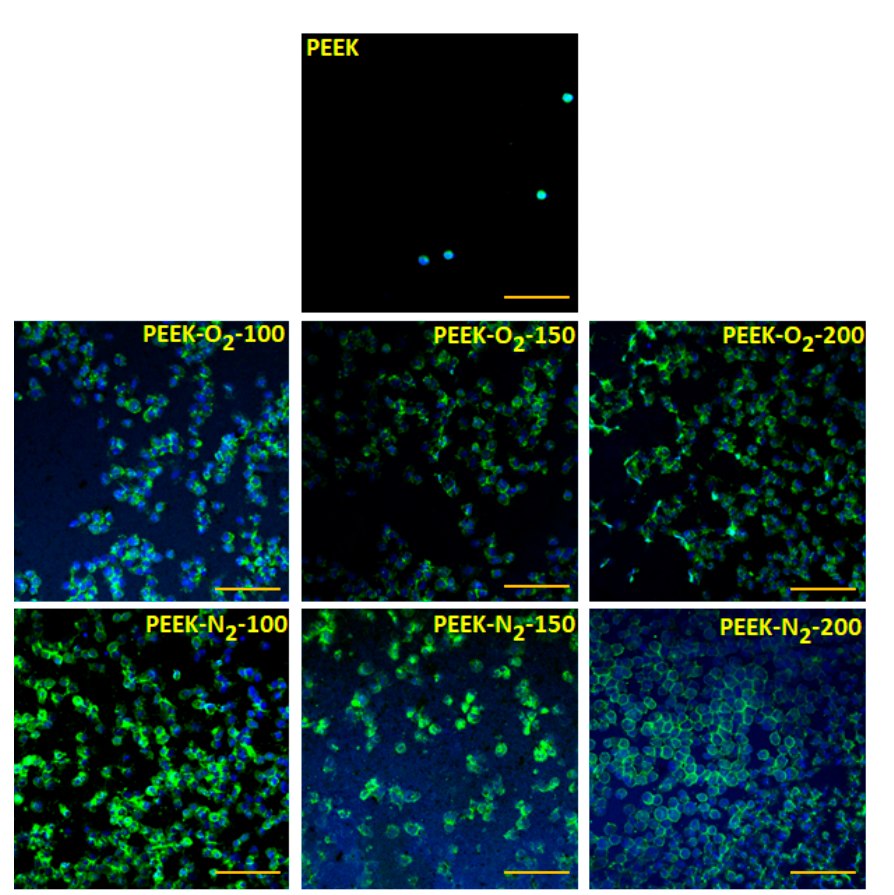
Figure 8. MG63 adhesion to the analyzed materials after 12 h of culture. Scale bar: 100 µm. Blue staining—nucleus (DAPI), green staining—actin (AlexaPhalloidin 488).